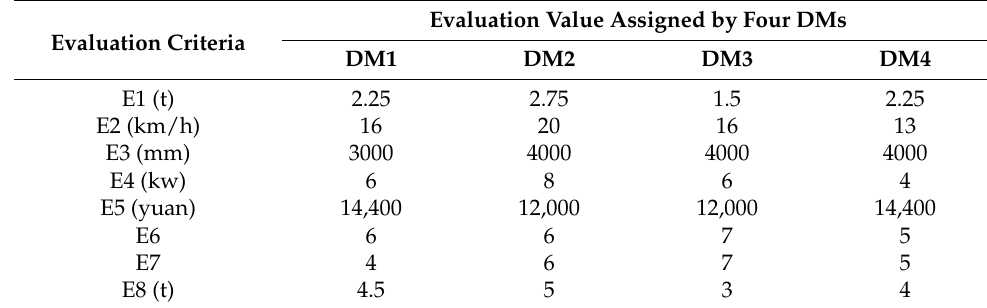
(b) Scheme Value Assessment of Evaluation Criteria on the Economy Evaluation